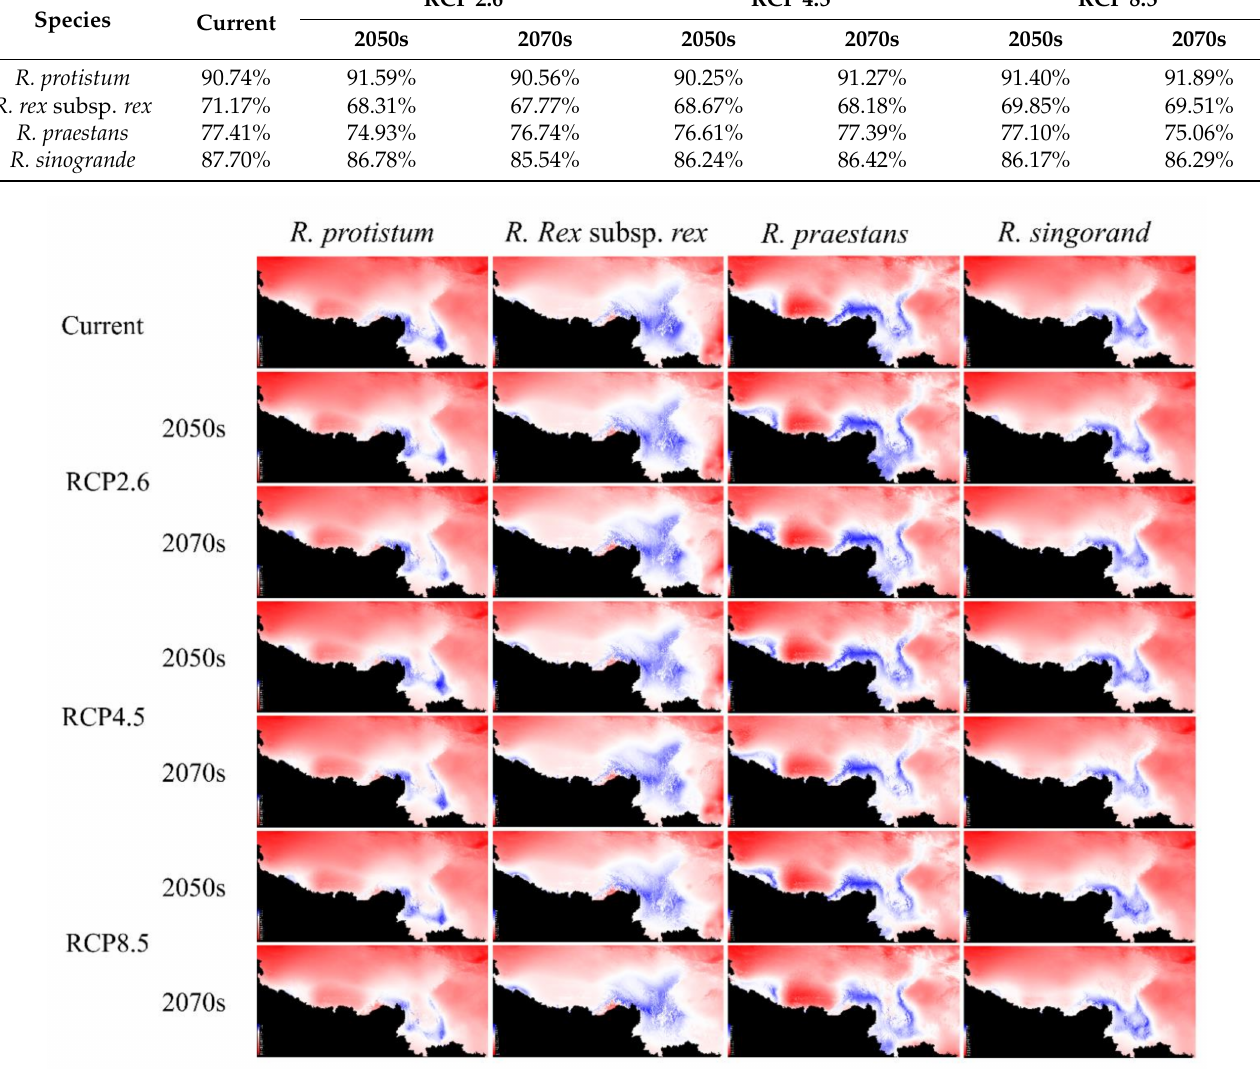
Figure A1. The multivariate environmental similarity surface (MESS) map output for four Rhododendron species in different periods under RCP 2.6, RCP 4.5, and RCP 8.5. Areas with different degrees of similarity by the white-blue colors (comprised between 0 and 1) and extrapolation areas are displayed in